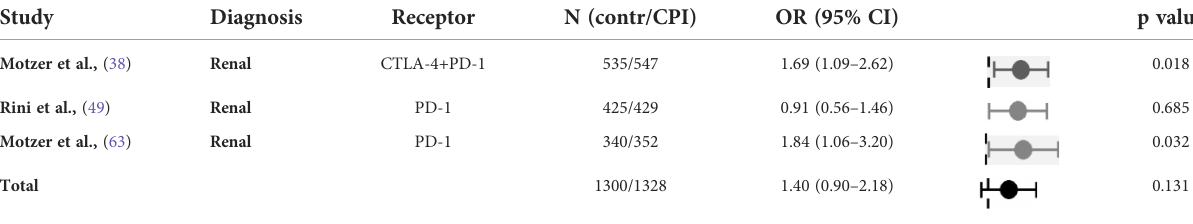
TABLE 7 Odds ratio of insomnia in randomised studies of checkpoint inhibitors versus non-immunologic targeted therapies (control arm as